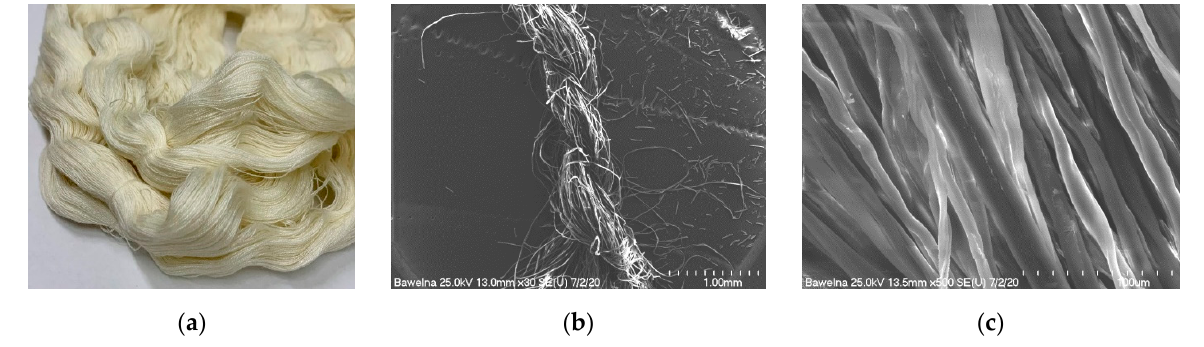
Figure 1. ( a ) Macroscopic photo of the cotton yarn used in this study; ( b ) SEM image at 30× magni- fication of the cotton yarn; ( c ) SEM image at 500× magnification of the cotton